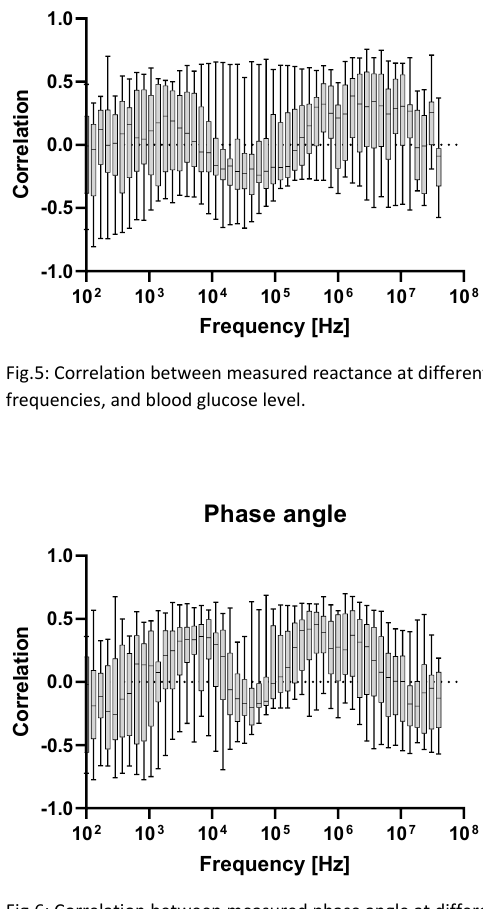
Fig.6: Correlation between measured phase angle at different frequencies, and blood glucose level.